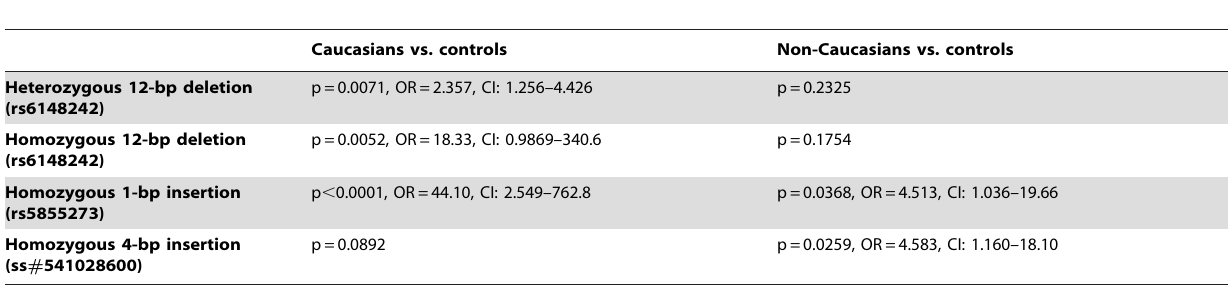
Table 4. Comparison of each of the BEEC patient groups against the ethnically-matched controls.